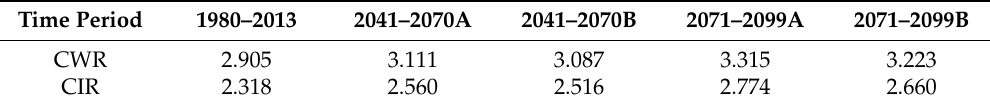
Table 3. CWR and CIR of HID in different time periods (×10 9 m 3 ).